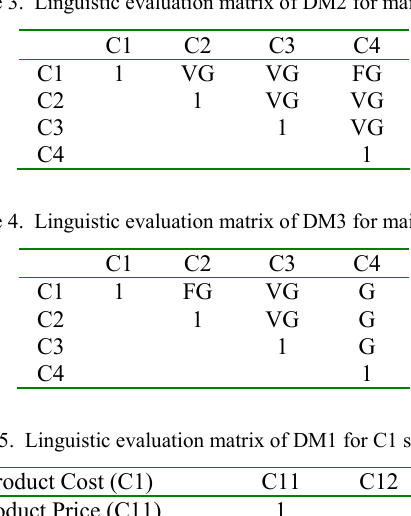
Table 3. Linguistic evaluation matrix of DM2 for main criteria